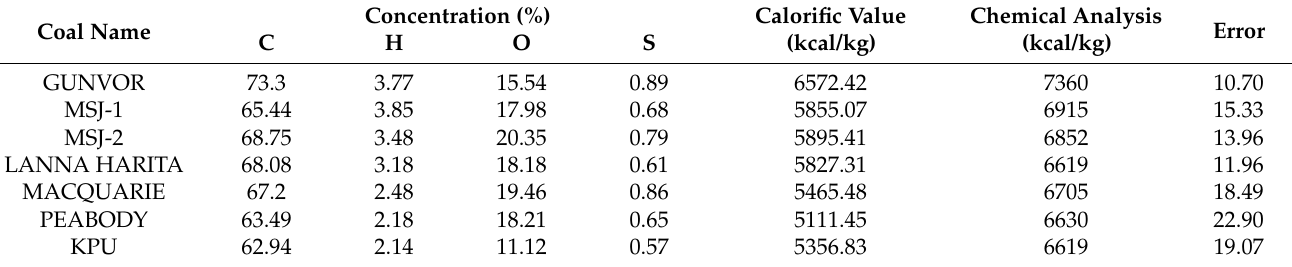
Table 4. Predicted calorific value of various coal samples by signal-to-noise ratio